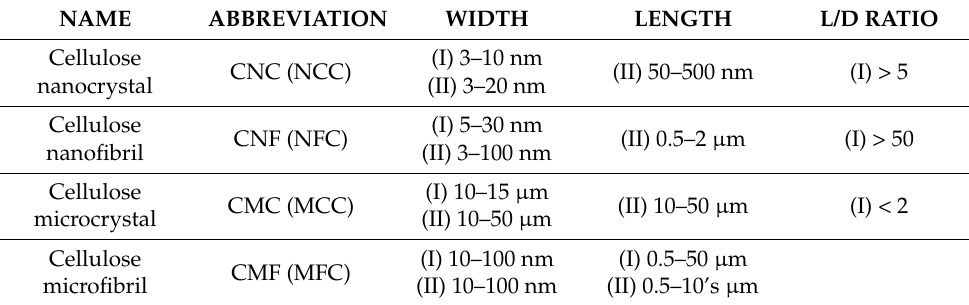
Table 1. Standardize terms for cellulose nanomaterials according (I) TAPPI/W123021 [42], and [II] cellulose nanomaterials review: structure, properties, and nanocomposite [50]. Each abbreviation have two alternatives. e.g., cellulose nanocrystal (CNC) and nanocrystalline cellulose